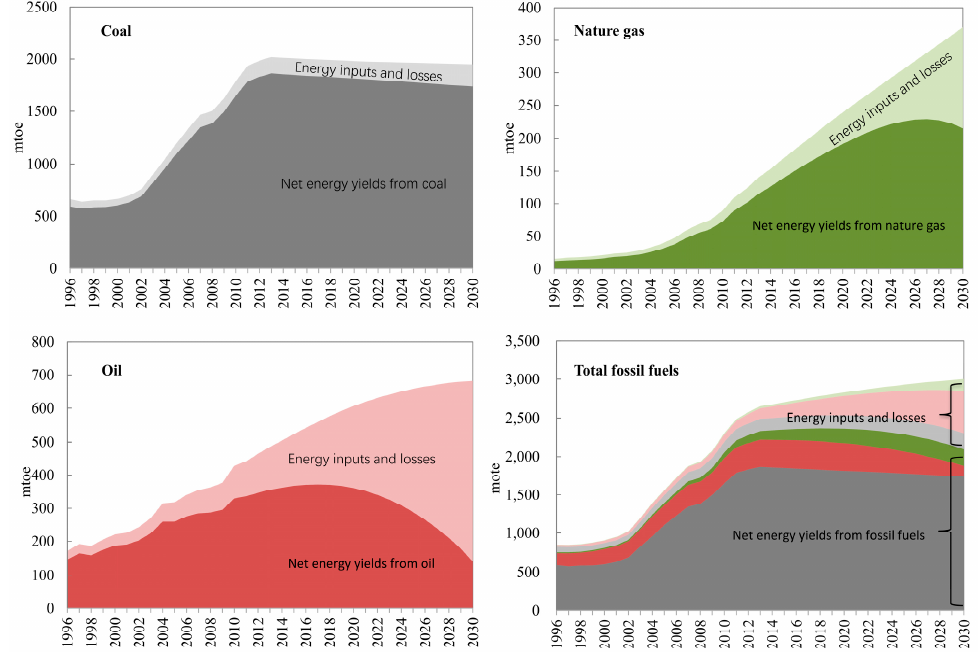
Figure 9. Net Energy yields from fossil fuels from 1996 to 2030, TPES means Total Primary Energy Supply. Blue area (dark + light) is TPES from natural gas, red area (dark + light) is TPES from oil, gray area (dark + light) is TPES from coal, green area (dark + light) is gross TPES from fossil fuels.